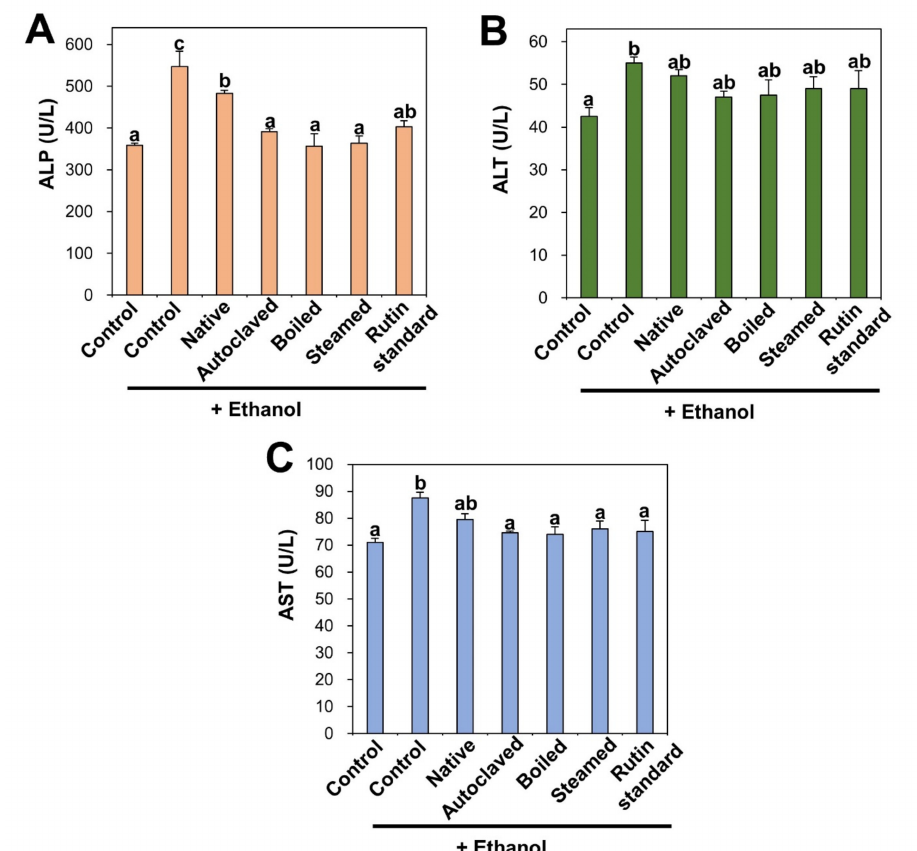
Figure 4. ( A ) alkaline phosphatase (ALP) ( B ) alanine aminotransferase (ALT) and ( C ) aspartate transaminase (AST) in serum after 28-day repeated oral administration of native, rutin-enriched TBFEs, and standard rutin, 5 h prior to ethanol administration. Di ff erent lowercase letters (a, b and c) indicate significant di ff erences among native, rutin-enriched (autoclaved, boiled, and steamed) TBFEs, and standard rutin ( p < 0.05).